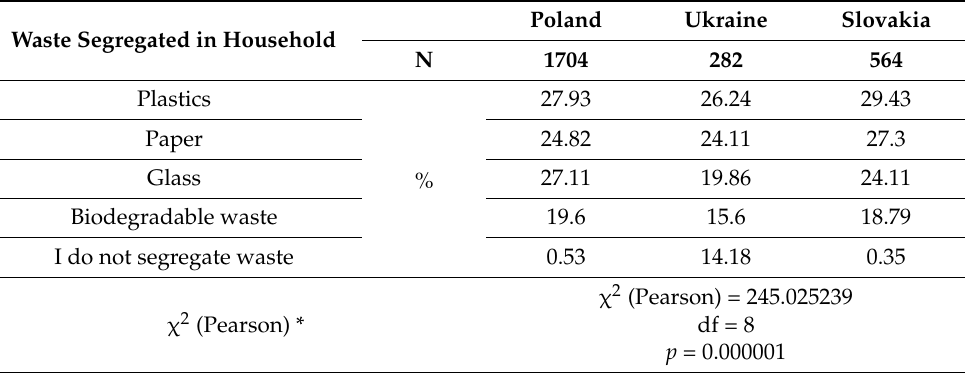
Table 10. Waste segregated at household level according to respondents from Poland, Ukraine and